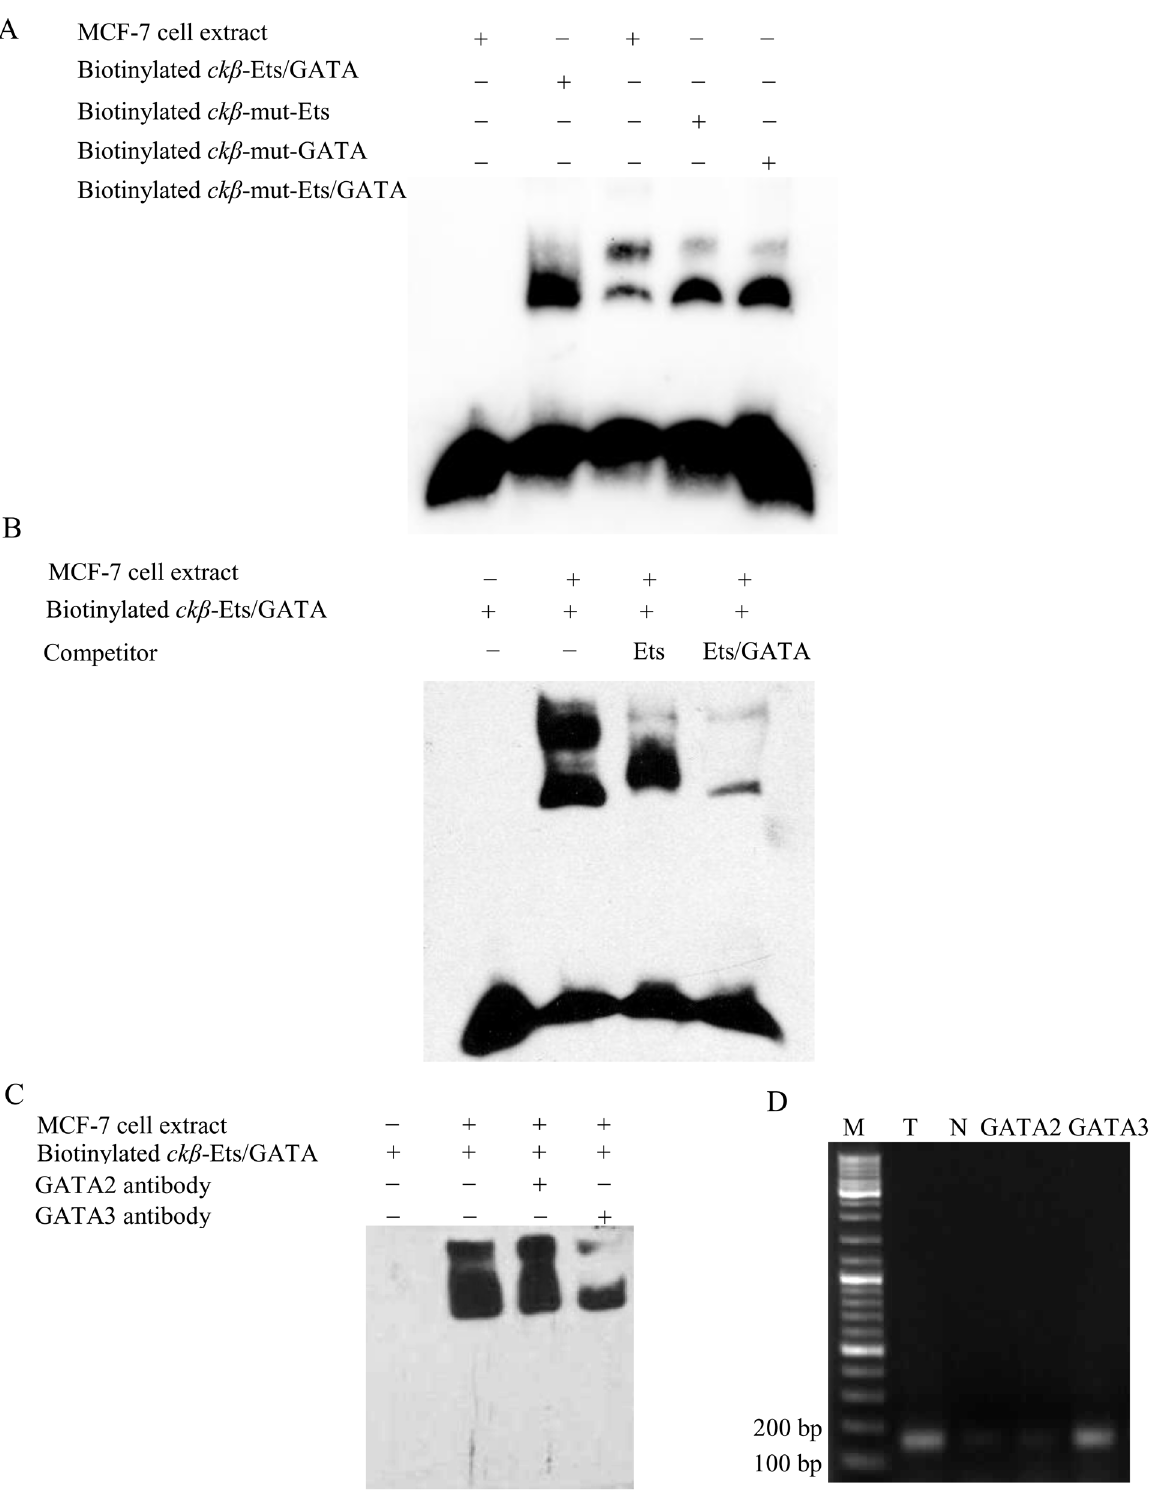
Figure 5. Characterization of Ets and GATA binding to the ck b promoter by EMSA and ChIP. (A) EMSA was performed by using biotinylated ck b -Ets/ GATA probes with or without mutations at the Ets and GATA binding sequence. The blot shown is representative of two independent experiments that produced similar results. (B) Competition assay was performed by using unlabeled Ets and Ets/GATA consensus probes as competitors in the EMSA.